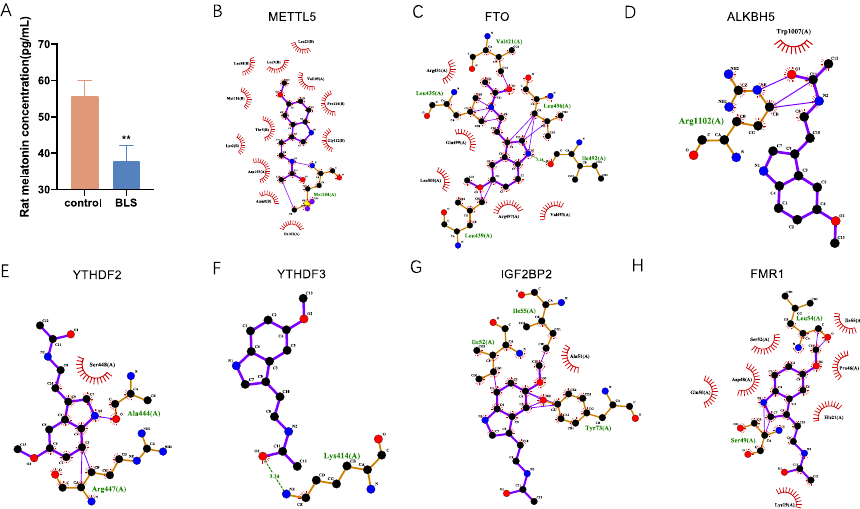
Figure 9. The secretion of melatonin and the molecular interaction between different expression regulators modified with m6A and carnitine. A two-dimensional interaction model is proposed. ( A ) Melatonin contents, ( B ) METTL3, ( C ) FTO, ( D ) ALKBH5, ( E ) YTHDF2, ( F ) YTHDF3, ( G ) IGF2BP2, and ( H ) FMR1. (** p < 0.01). Table 3. Molecular interactions between melatonin and m6A modified different expression regulators.